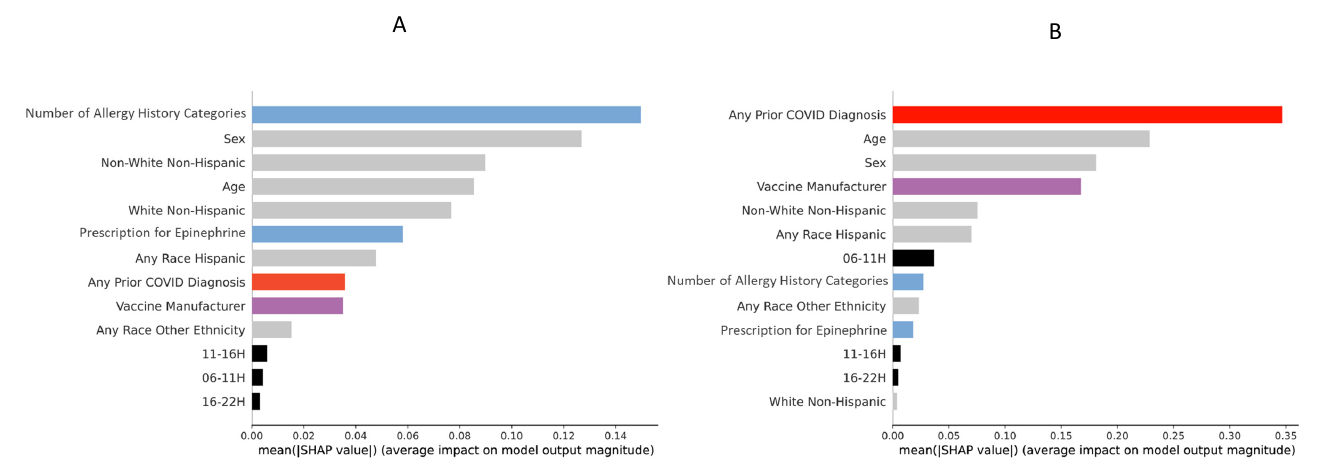
Figure 2. Feature importance plot using the mean absolute SHAP values for ( A ): allergic side effects and ( B ): non-allergic side effects. Colors: grey—demographics, blue—allergy history cate- gory/prescription for Epinephrine, red—any prior COVID diagnosis or positive test, purple—vaccine manufacturer, black—time-of-day of